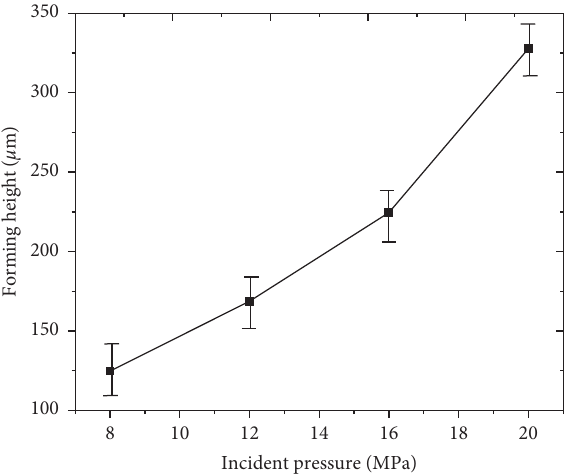
Figure 5: Influence of incident pressure on forming